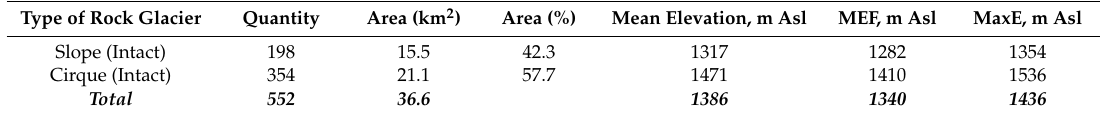
Table 5. Statistics of Rock Glaciers of the Verkhoyansk Range.